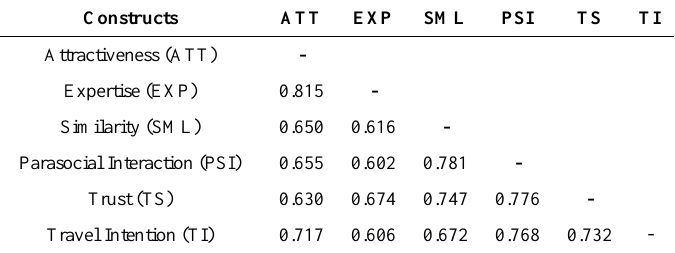
Table 6. Heterotrait-Monotrait Ratio (HTMT)